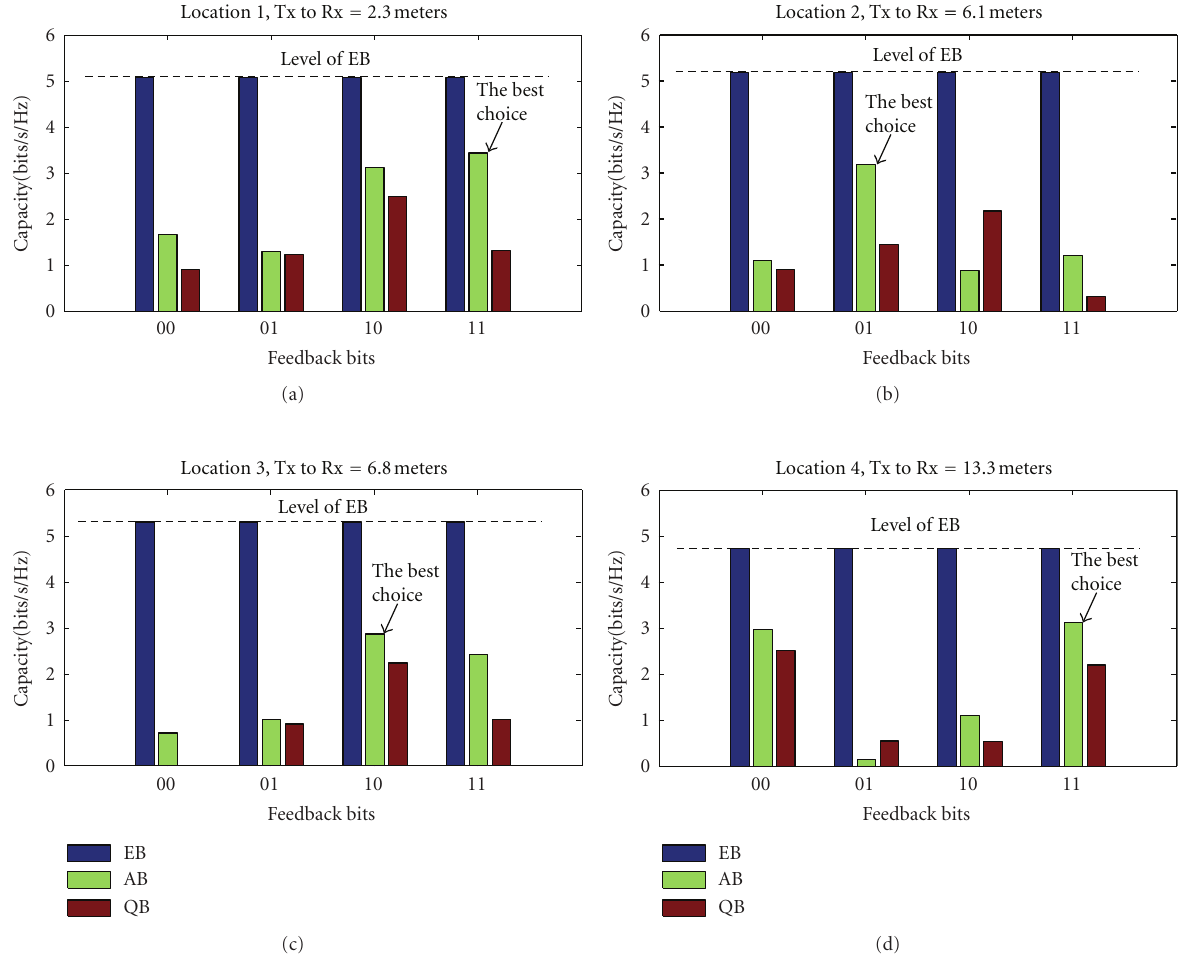
Figure 9: Average capacity versus beam direction for two-bit feedback, locations 1, 2, 3, and